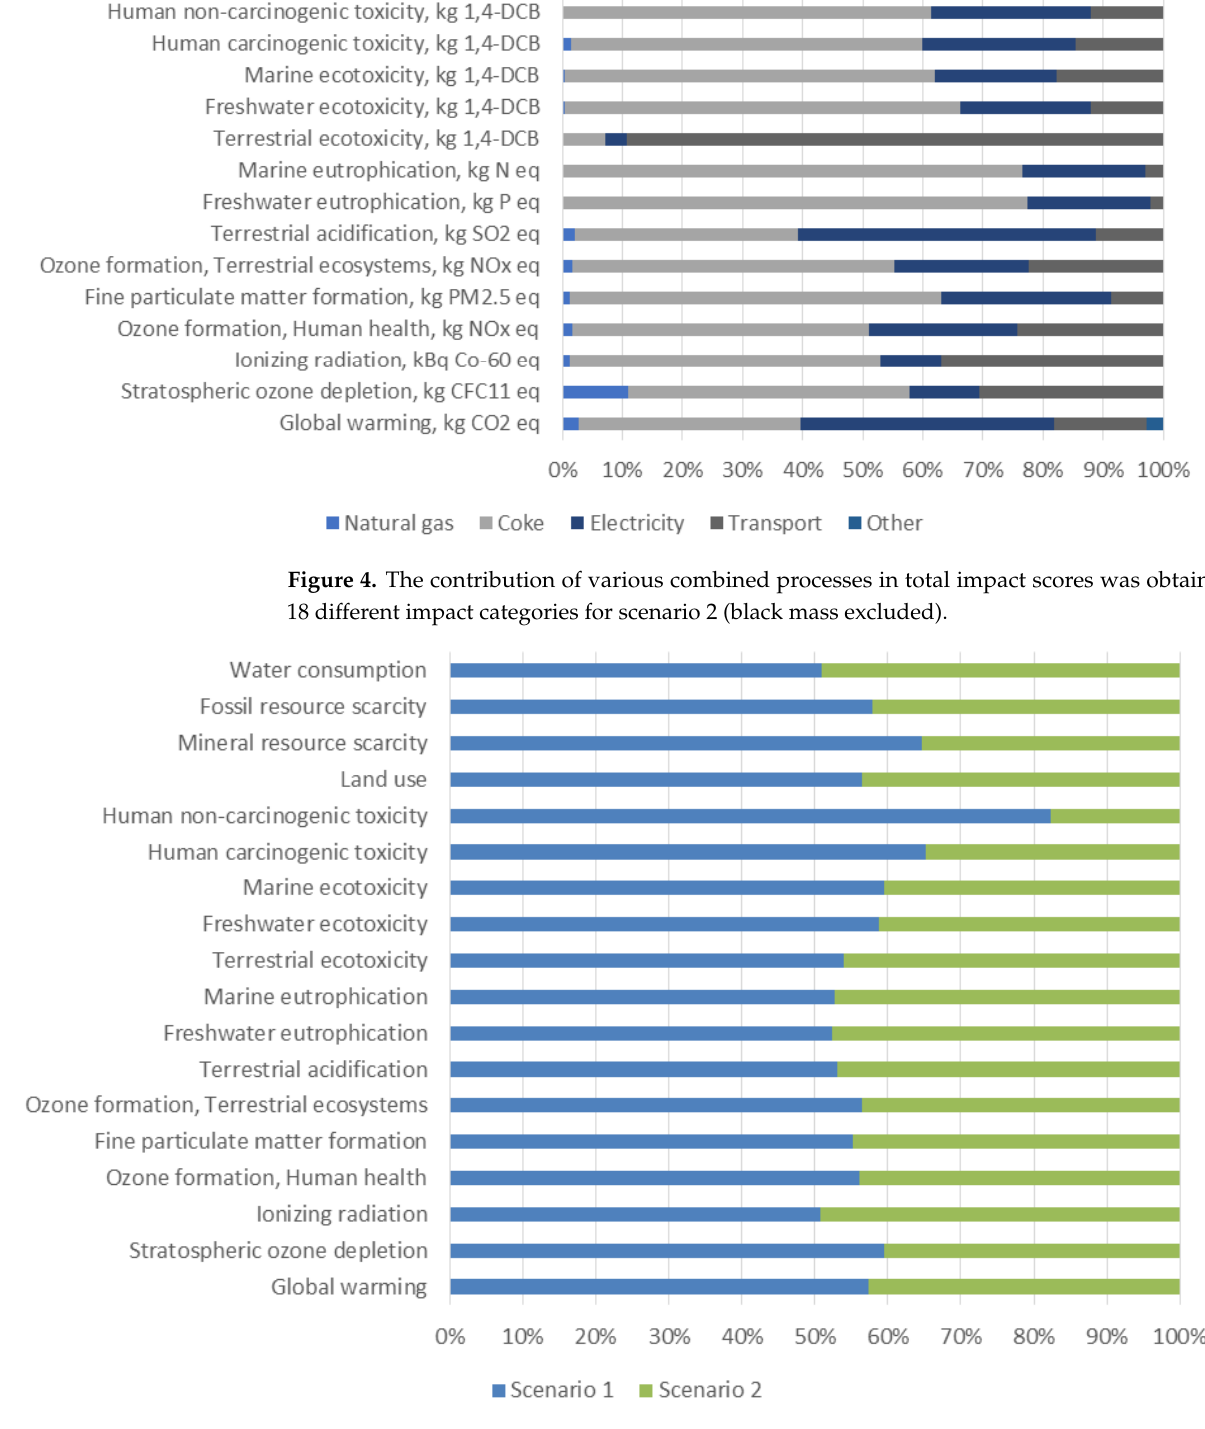
Figure 5. Comparison of the environmental performance of both studied scenarios in terms of their dominance in all of the 18 impact categories available in the ReCiPe 2016 Midpoint (H) method.